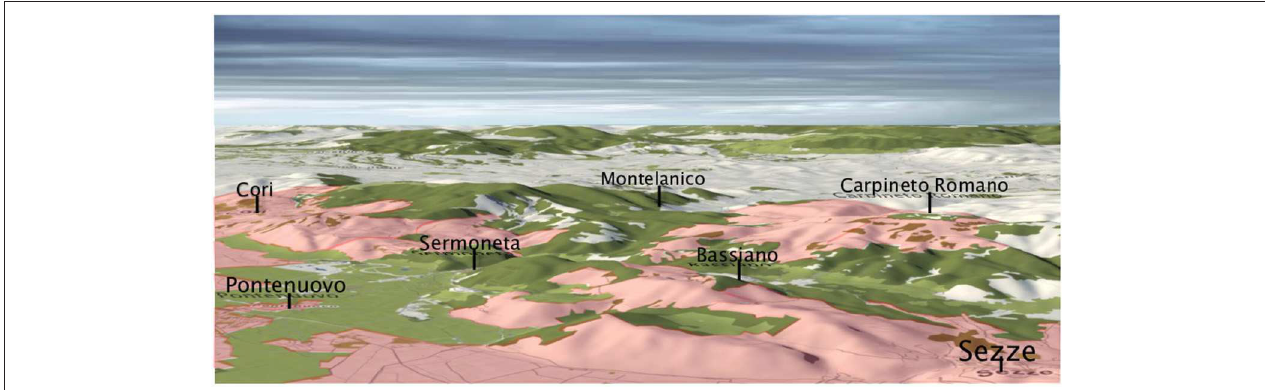
FIGURE 6 | Spatial patterns of kriged-probability perspective view exceeding the erosivity density threshold-value z k of 3 MJ ha − 1 h − 1 with probability > 50% (pink color) for October across the Latina Province (Southern Latium) for the period 2002–2011. Wood areas are in green